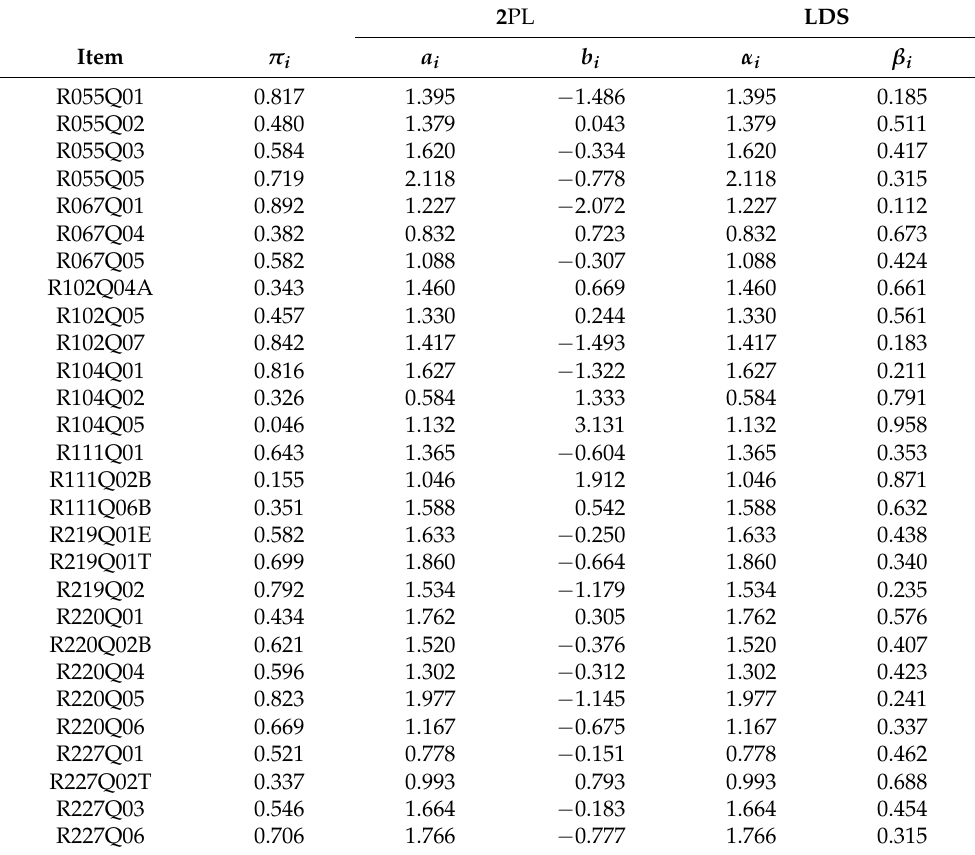
Table A1. Estimated item parameters for the PISA 2006 reading dataset.